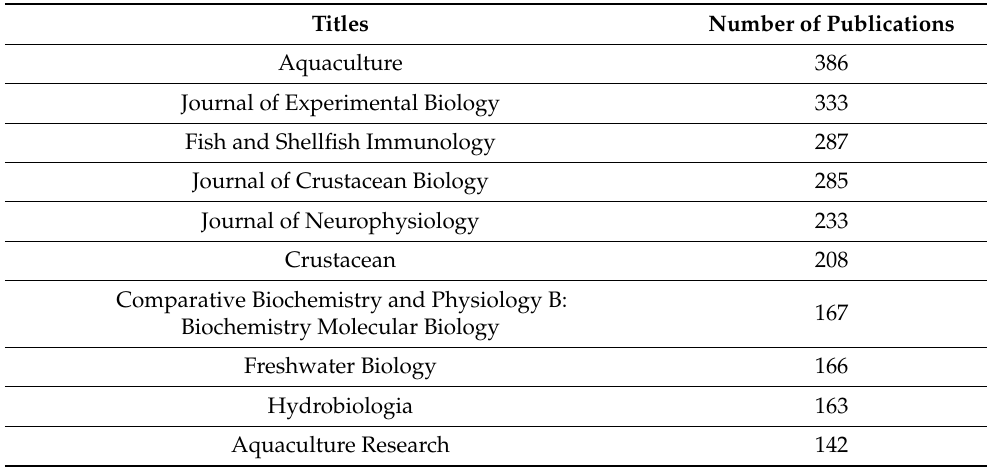
Table 3. Primary or secondary sources (journals) used for the literature search and scientometric